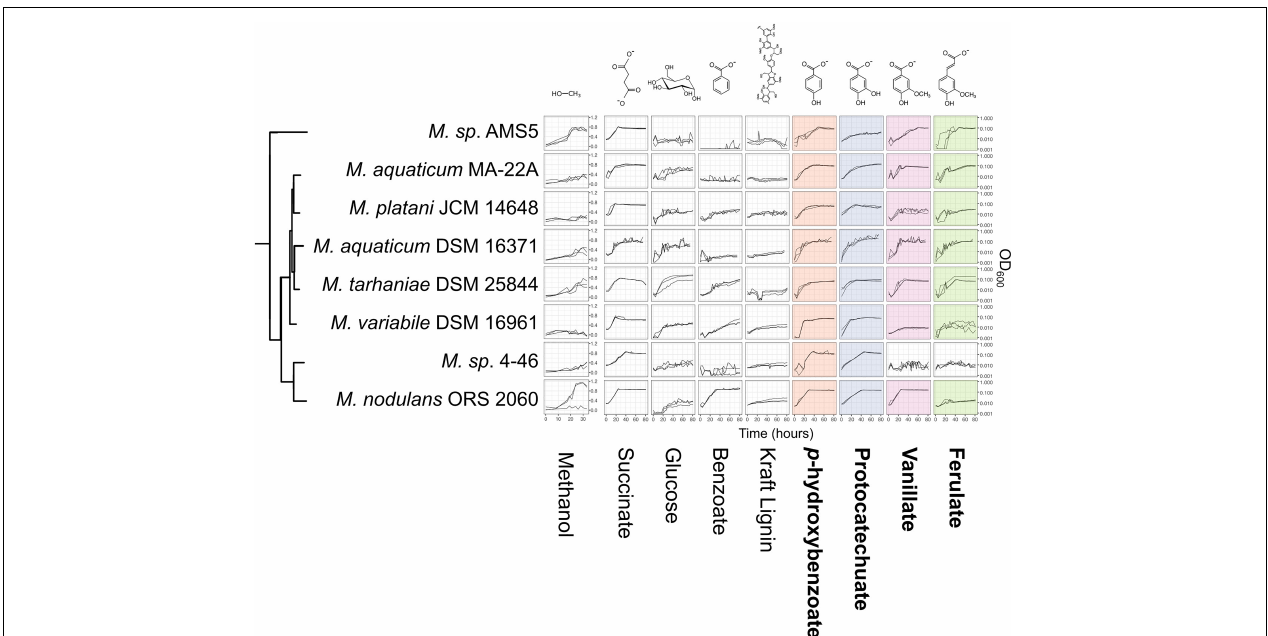
FIGURE 5 | Growth of Methylobacterium species on aromatic compounds is predicted by genome content in most cases. Methylobacterium species were grown in defined mineral medium with a single carbon substrate; all conditions contained 16 mM of carbon. Substrates corresponding to the four degradation pathways featured in this study are outlined labeled in bold type, and presence of the corresponding genes in each strain’s genome is indicated by colored shading (as in Figure 1 ). Lines show growth curves from three biological replicates. Note that the y -axis for methanol is on a different scale, as these cultures were grown in different vessels. There were only 3 cases (out of 32) in which organisms had the genes associated with degradation of a given substrate but showed little or no growth. There were no cases in which organisms grew on substrates for which they did not have the associated genes. Source data are available in Supplementary Tables 4, 5 .